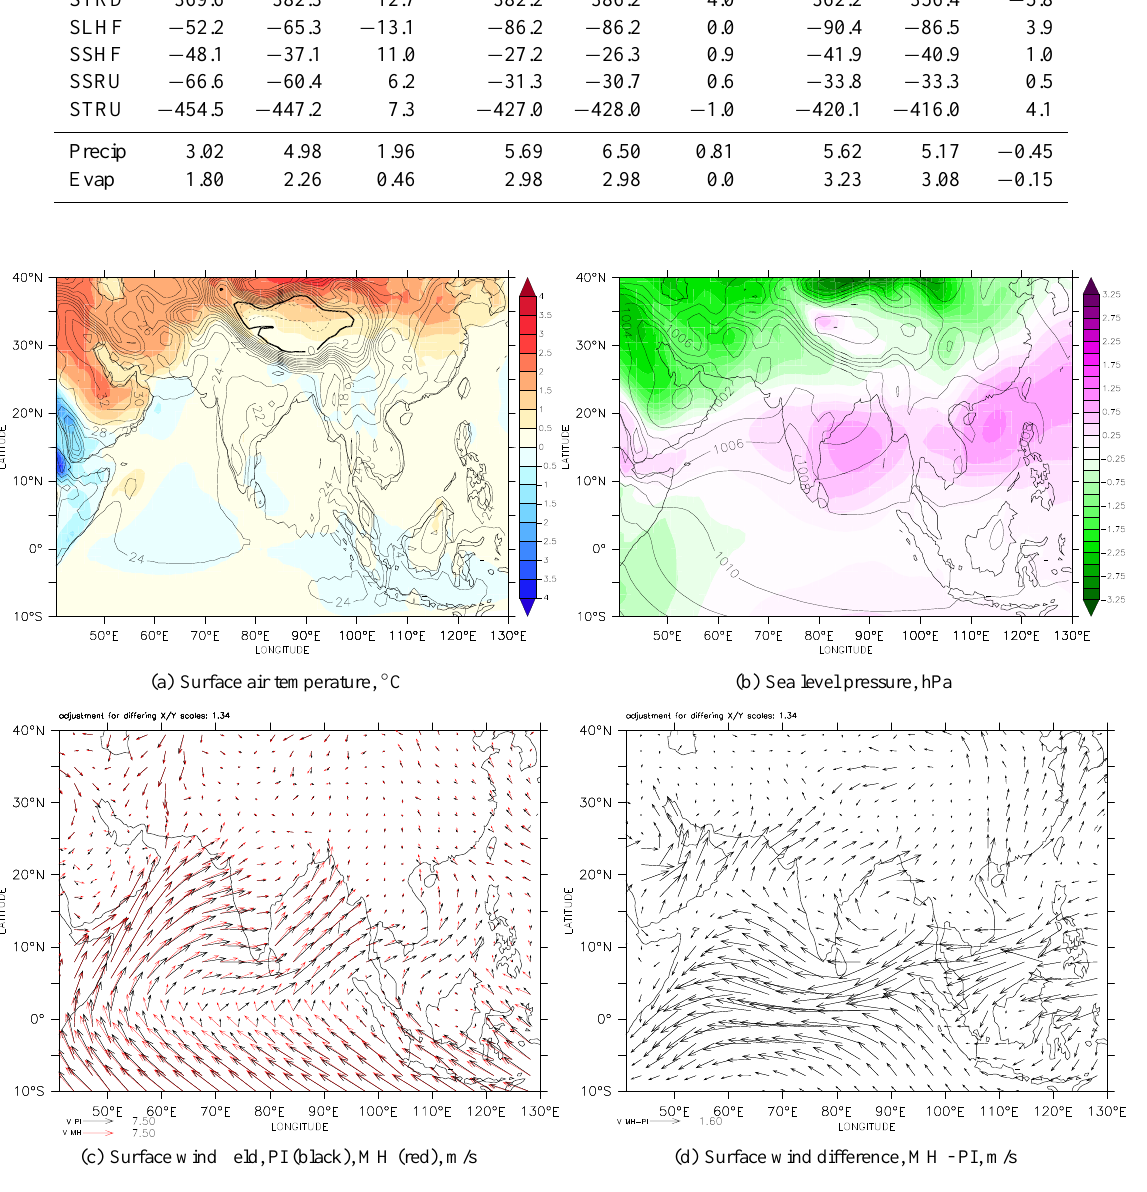
Fig. 10. MH-PI difference in JAS surface air temperature – (a) , ◦ C – and sea-level pressure – (b) , hPa; contours are PI values, colours indicate differences between MH and PI. (c) Shows the PI surface wind field (black) and the MH surface wind field (red), unit length is 7.5ms − 1 , (d) gives the difference between the MH and PI wind field, unit length is 1.6ms − 1